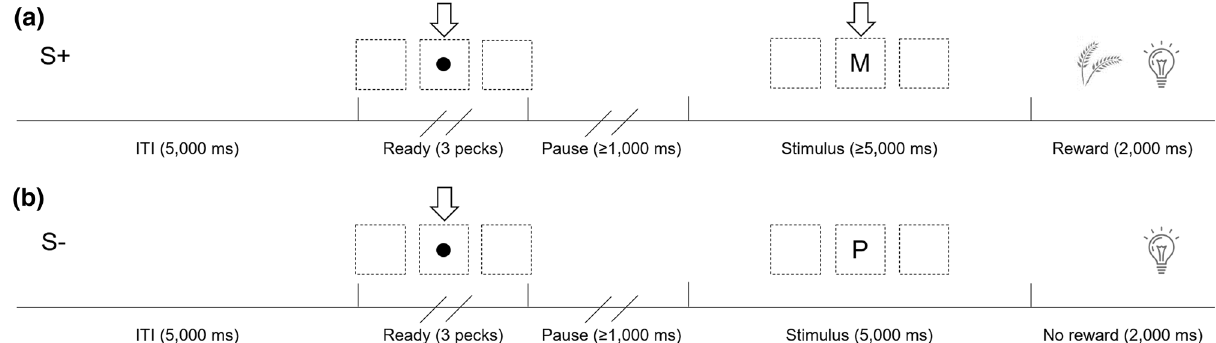
Figure 1. The sequence of events during an S+ trial ( a ) and an S− trial ( b ). Both trials began with a 5000 ms intertrial interval (ITI), followed by the ready period in which a black dot appeared on the screen. After pecking the dot three times, the pause period was initiated in which the birds were required to refrain from pecking for at least 1000 ms. Following the pause period, one of the 14 painting stimuli appeared for a minimum of 5000 ms, during which time pecks were recorded. If an S+ stimulus was displayed, the birds were rewarded following the first peck after 5000 ms, and the stimulus turned off. If an S− stimulus was displayed, they were required to wait 5000 ms until the stimulus disappeared automatically, and were not rewarded. Wheat reward was delivered by a food hopper for 2000 ms on S+ trials, and S− trials had a matching 2000 ms period with no reward. M, Monet painting; P, Picasso